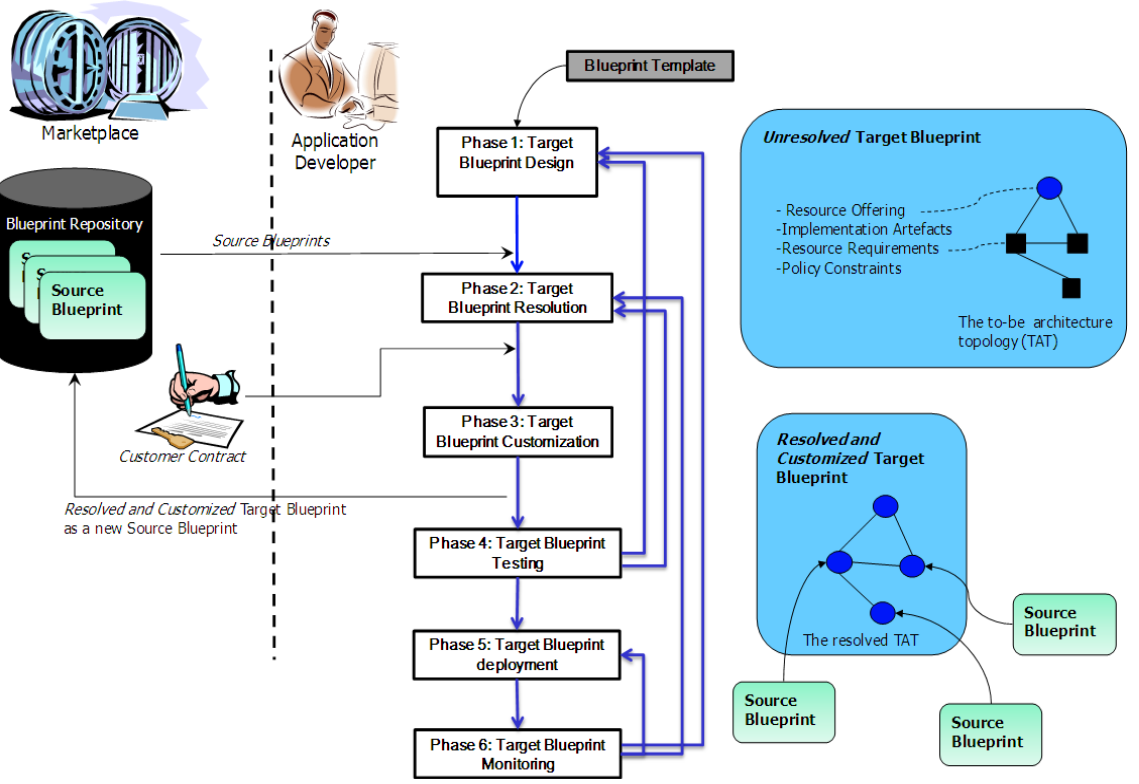
Figure 7. The Blueprint